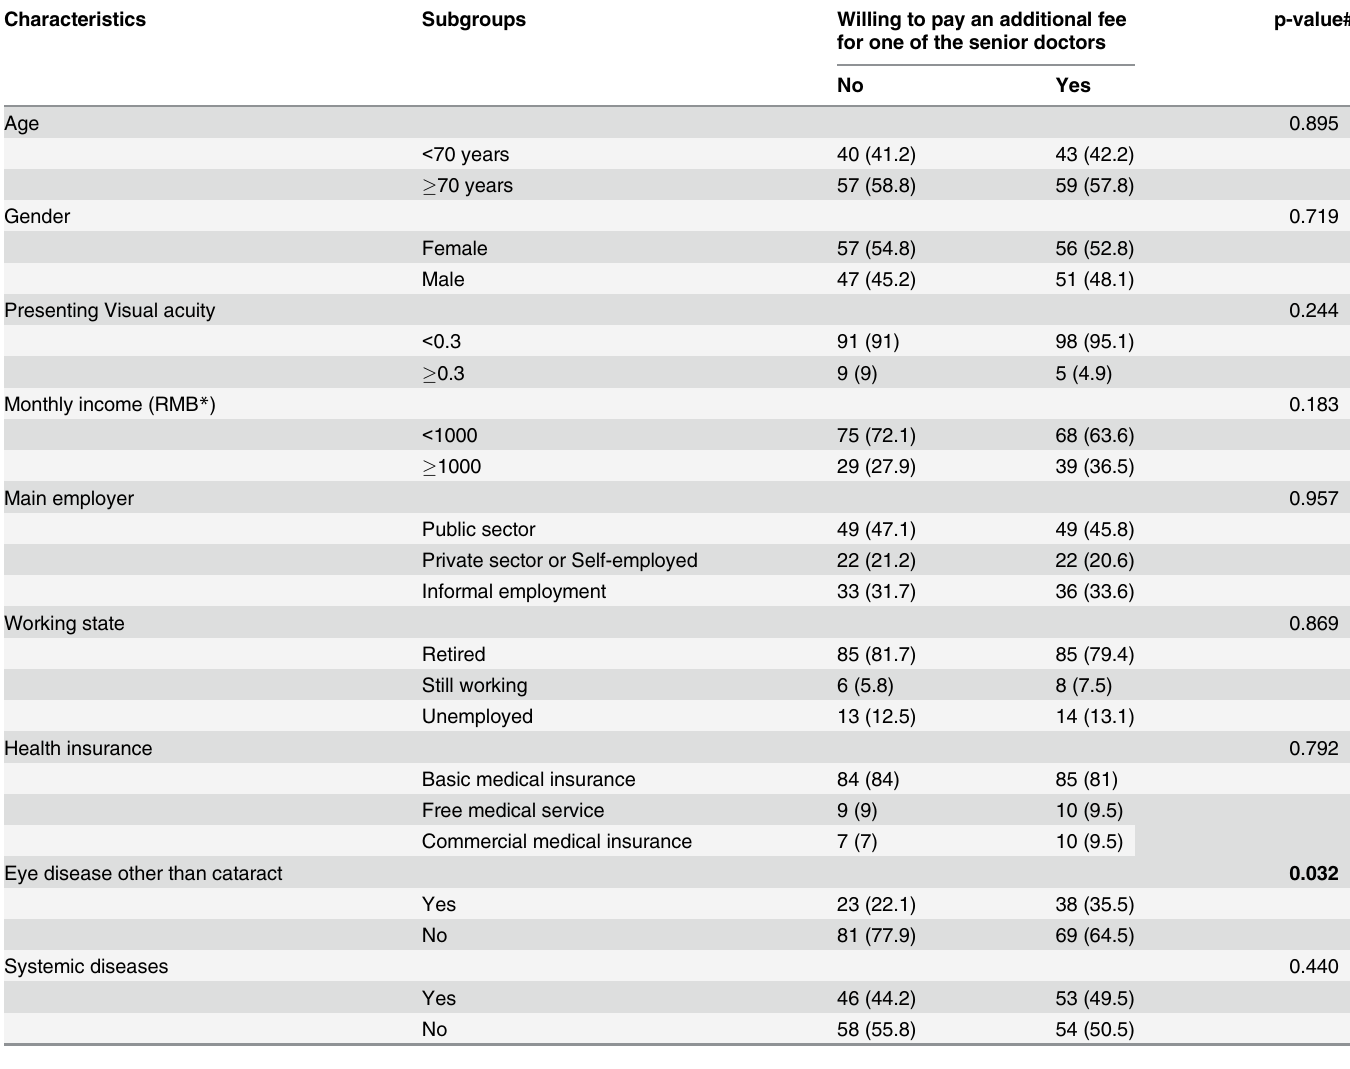
Table 2. Analysis of willing to pay an additional fee for surgery performed by a senior surgeon, Guangzhou,